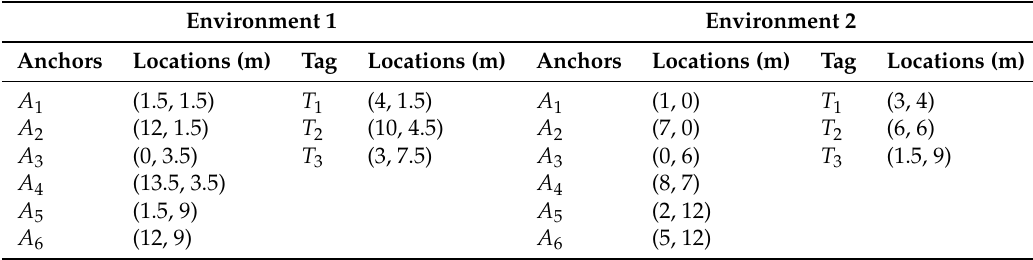
Figure 5. Environment 2: Computer laboratory that is equipped with 6 BLE estimotes used to estimate 3 tag locations. Table 3. Locations of Anchors and